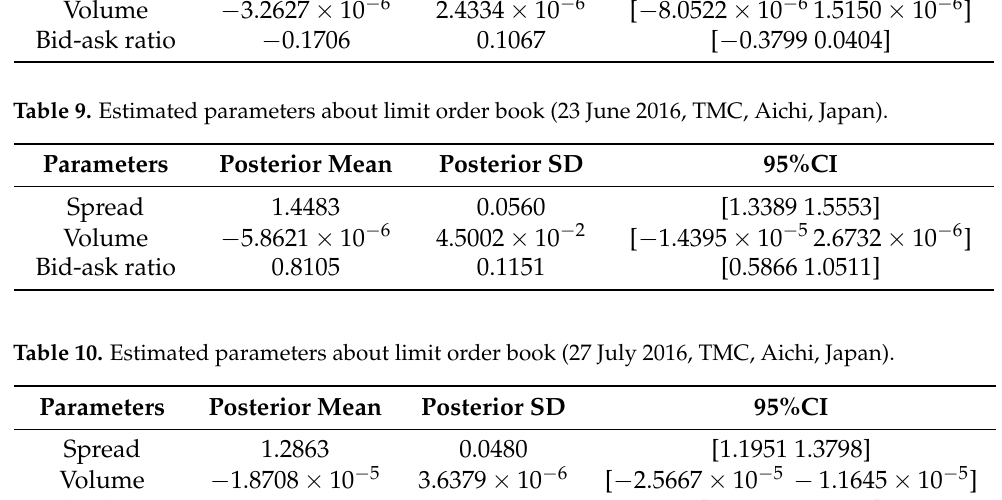
The best of each distribution is underlined, and the best overall is in bold. Table 8. Estimated parameters about limit order book (4 January 2016, TMC, Aichi, Japan). Parameters